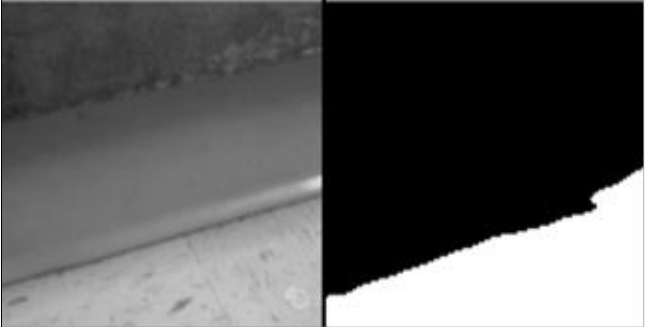
Figura 8: Detección de paredes usando la función inRange(). Fuente: Los autores,